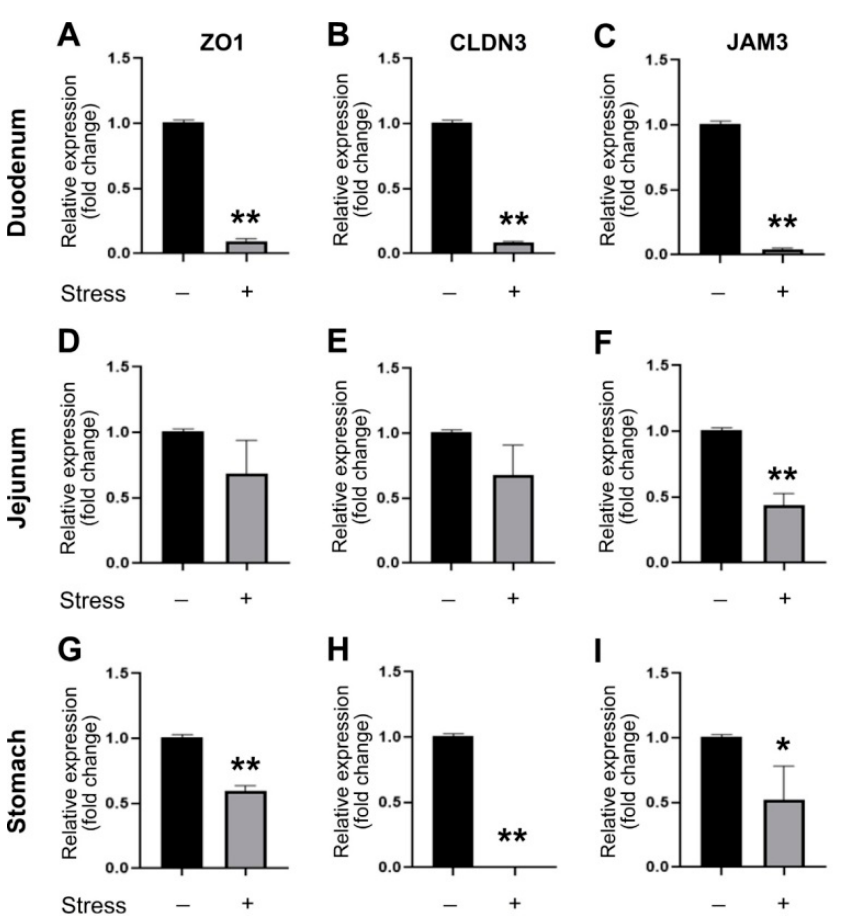
Figure 2. Relative mRNA expression levels of tight junction genes. Through qRT-PCR analysis, the relative mRNA expression levels of tight junction genes ZO-1 ( A , D , G ), CLDN3 ( B , E , H ), and JAM3 ( C , F , I ) and of the mouse duodenum ( A – C ), jejunum ( D – F ), and stomach ( G – I ) with or without 9 h of restraint stress. The mRNA expression levels of the control (no stress) groups were normalized to 1-fold. n = 3 (2 experiments with a total of 3 mice per group). * p < 0.05 and ** p < 0.01 vs. their respective no stress control groups. The “stress − “ indicates no stress control groups and the “stress +” indicates the stressed groups.